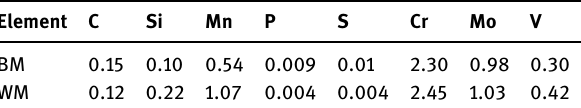
Table 1: Chemical compositions ( wt% ) of BM and WM in the 2.25Cr1Mo0.25V steel welded joint Element C